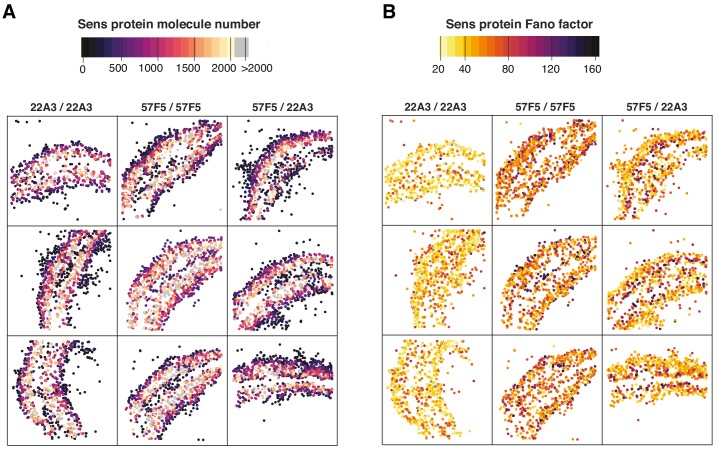
Maps of Sens protein number and Fano factor in replicate wing discs.(A, B) Spatial maps of cell coordinates from individual wing discs. Three representative wing discs with homologous allele pairs for sens at 22A3 (left), 57F5 (center) and the non-homologous pair 57F5/22A3 (right) are shown. Cell centroids are color coded according to their corresponding (A) Sens protein number or (B) Fano factor. Color scales on top. Only cells with fewer than 2000 molecules of Sens are plotted for ease of visualization.